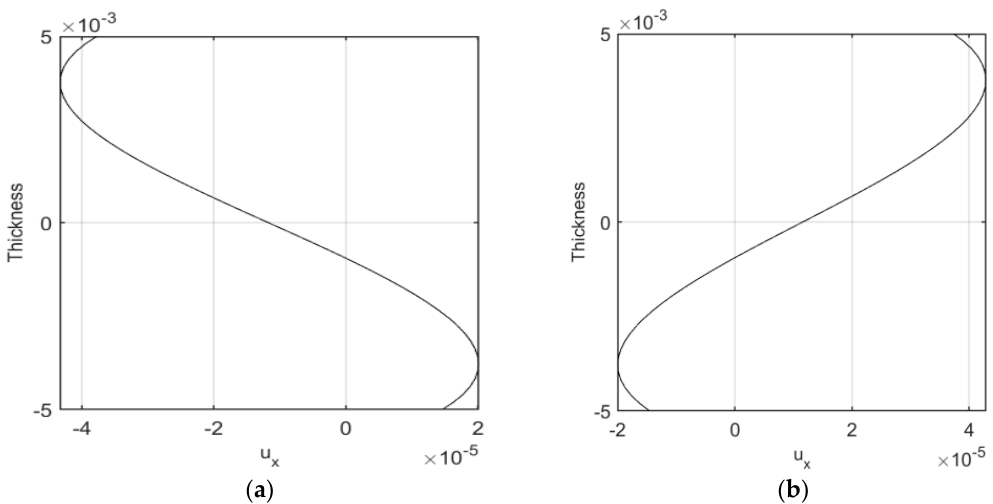
Figure 12. Maximum values of the axial deformation along the thickness direction at different longitudinal positions, at x = 0.1 ( a ) and x = 0.4 ( b ).